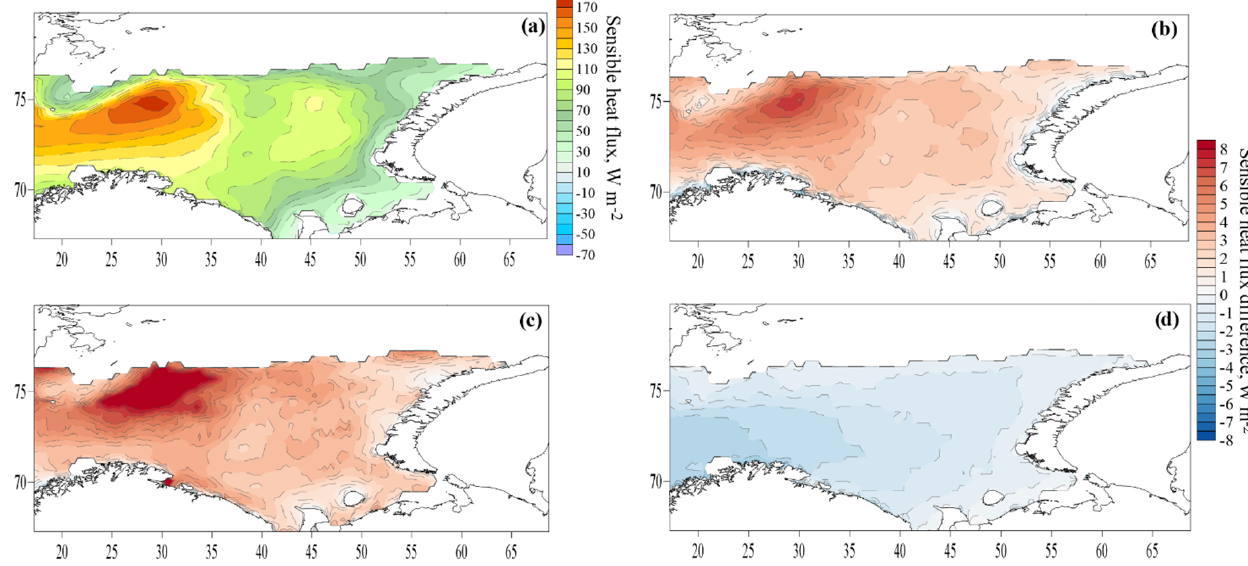
Figure 18. Mean sensible heat flux in experiment C55 (a) and the flux difference in experiments T1–C55 (b) , O2–C55 (c) and D3–C55 (d) during simultaneous storms and cold-air outbreaks.